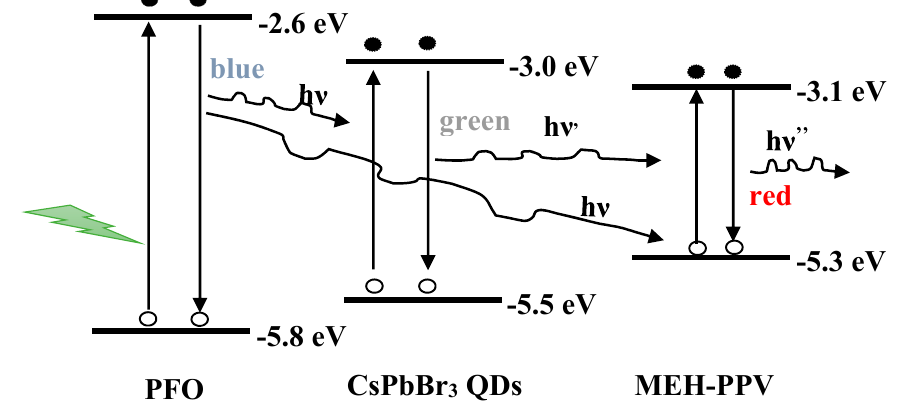
Figure 5. Scheme of the triplet Förster resonance energy transfer (FRET) in the PFO/MEH-PPV/PQDs hybrids.